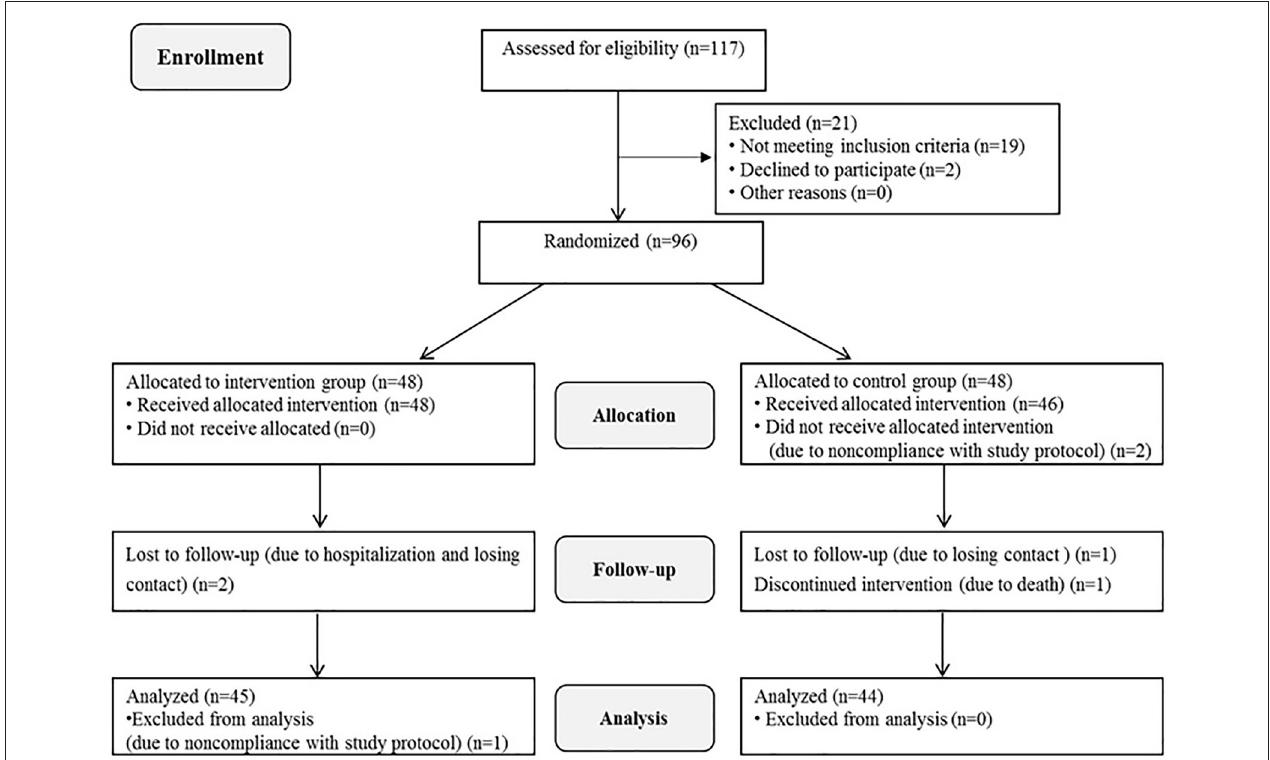
FIGURE 1 | Consort participant flow